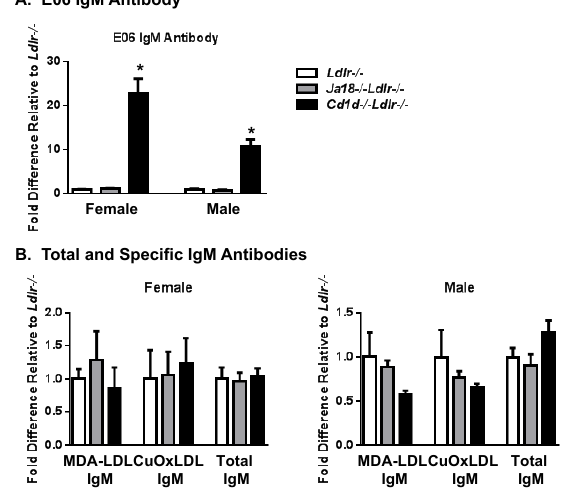
Figure 1. Selective increase in E06 IgM antibody in the plasma of Cd1d −/− Ldlr −/− mice. Relative plasma IgM titers specific for ( A ) E06 IgM (1:100 dilution), and ( B ) MDA-LDL (1:200 dilution), Cu-OxLDL